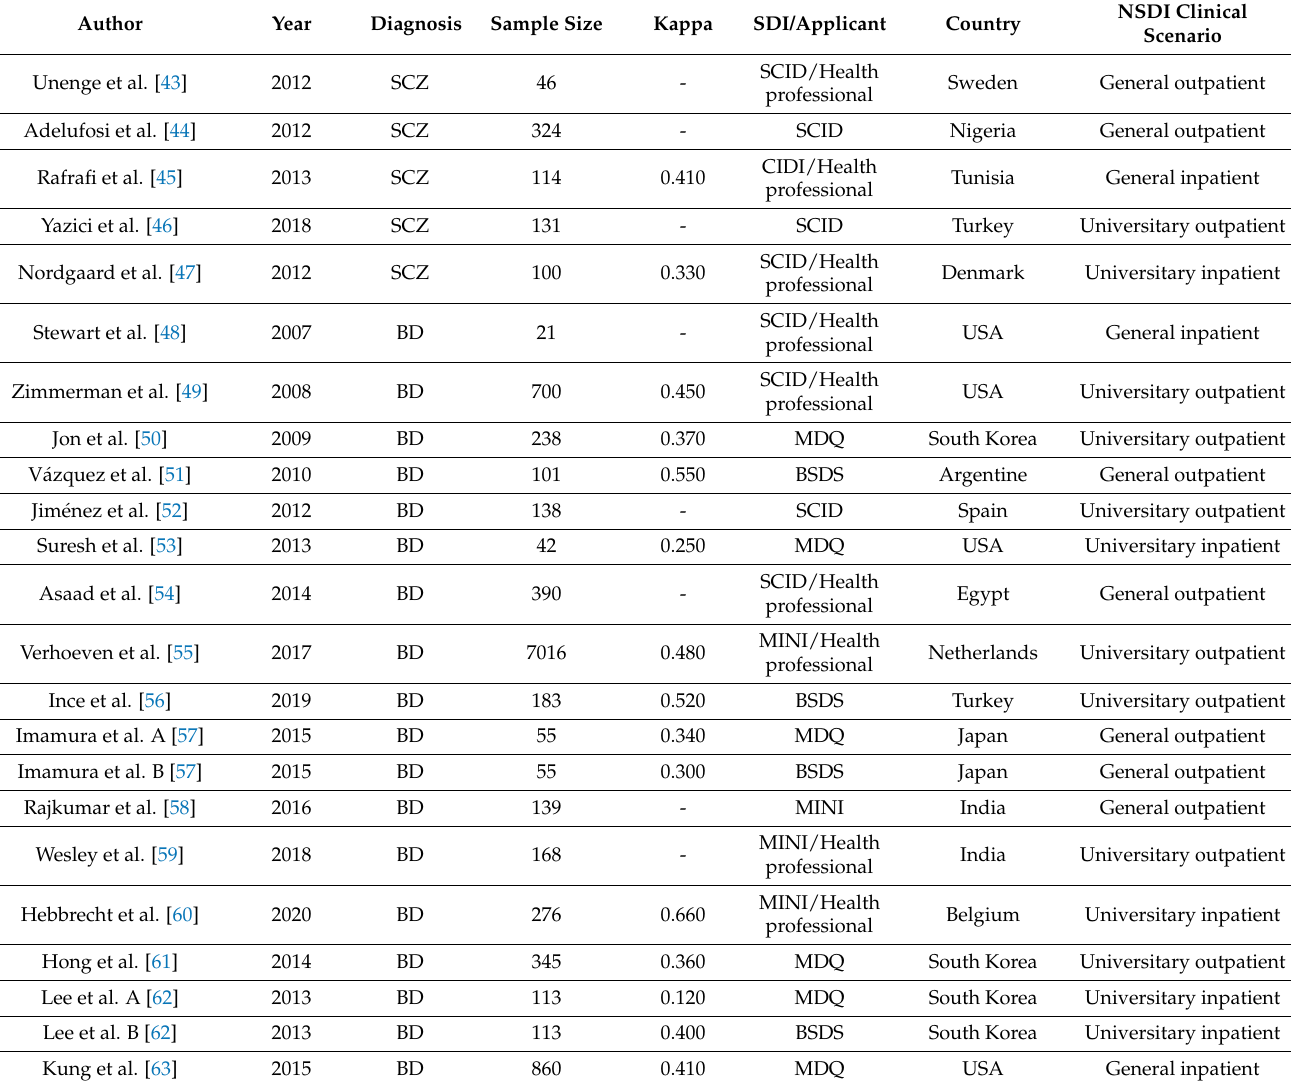
Table 3. Selected papers by author, year, diagnosis, sample size, kappa, applied SDI, sample country, clinical scenario, NSDI scenario and SDI